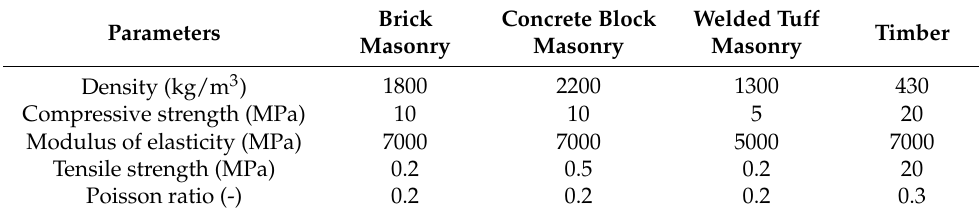
Table 2. Material properties adopted to the numerical